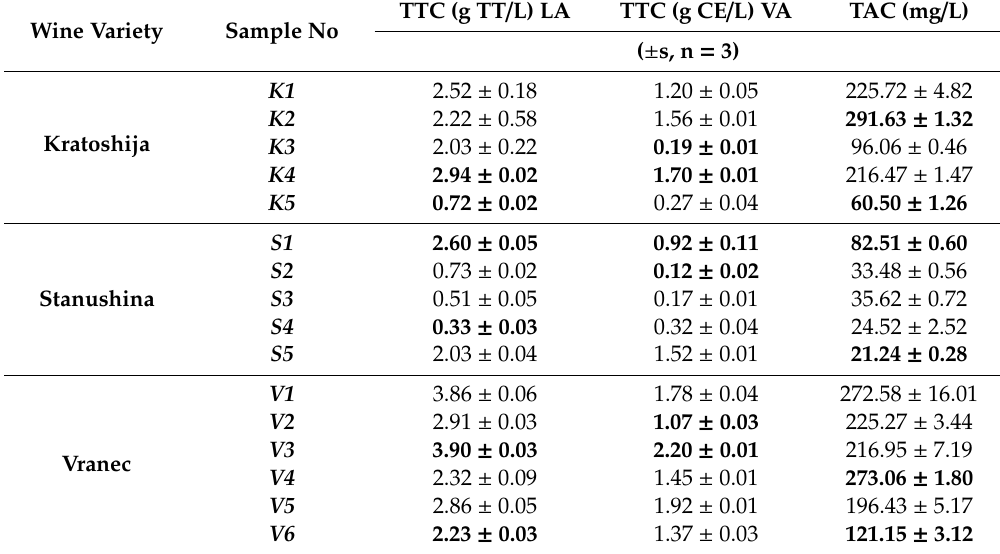
Table 2. Total tannin content (TTC) by the leucoanthocyanin (LA) method and the vanillin assay (VA) and total anthocyanin content (TAC) of the three red varieties examined (the lowest and the highest values within each variety are shown in bold)